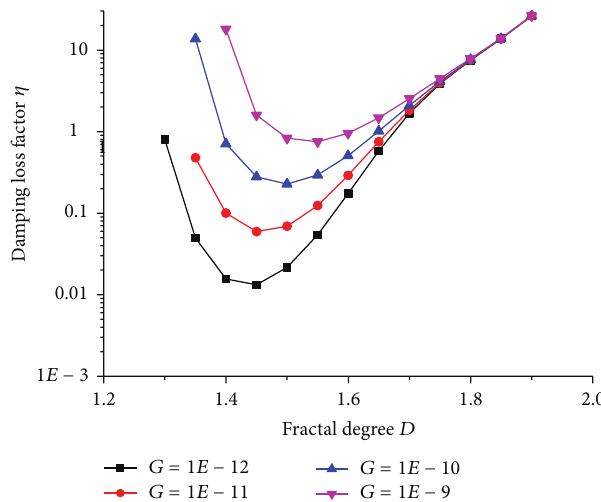
Figure 6: Relationships between 𝜂 and 𝐷 .